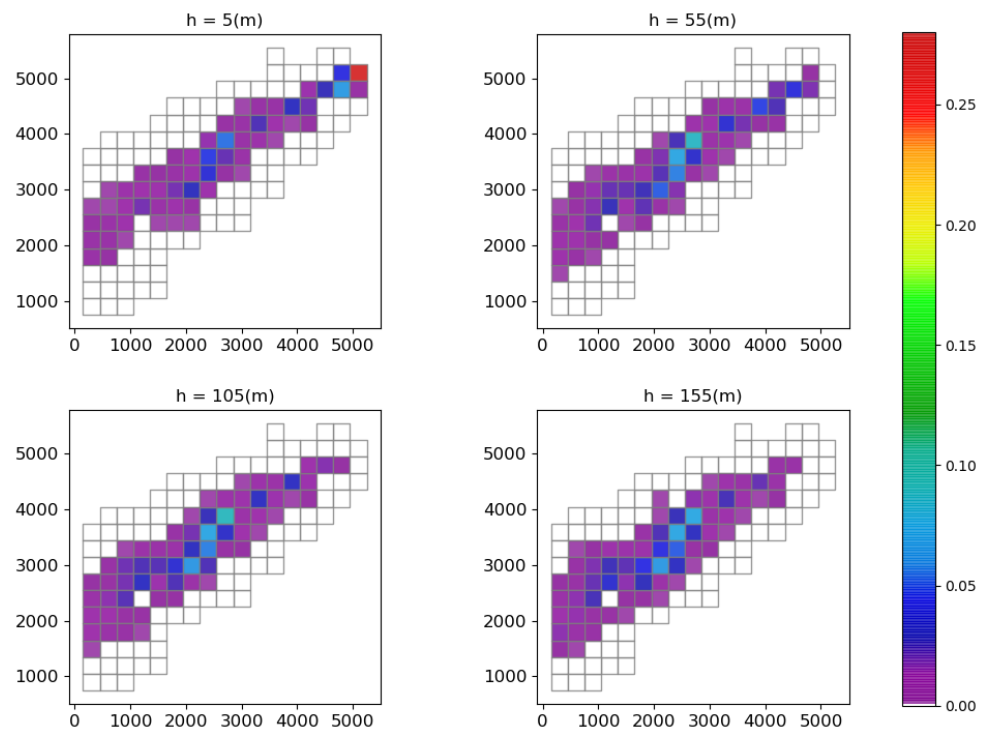
Figure 7. The relative contribution of different cells to the pollutant concentration at the second POI (case 3; located at ( 5000,5000 ) ) at four heights for third case is